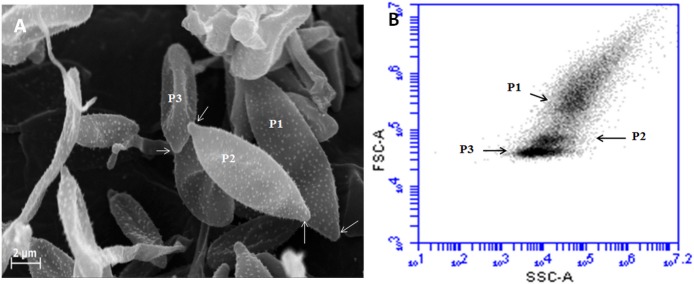
SEM views of the three different populations of aerial sporidia.A: Large sporidia (P1), medium-sized sporidia (P2) with two scars (arrows) and small sporidia (P3) with one scar only. B: Flow cytometry analyses corresponding to the AS sample, revealed different morphotypic sub-populations (results were displayed on Forward Scatter Air/Forward Scatter Height (FSC-A/FSC-H) dot-plot on the basis of 40,000 events).